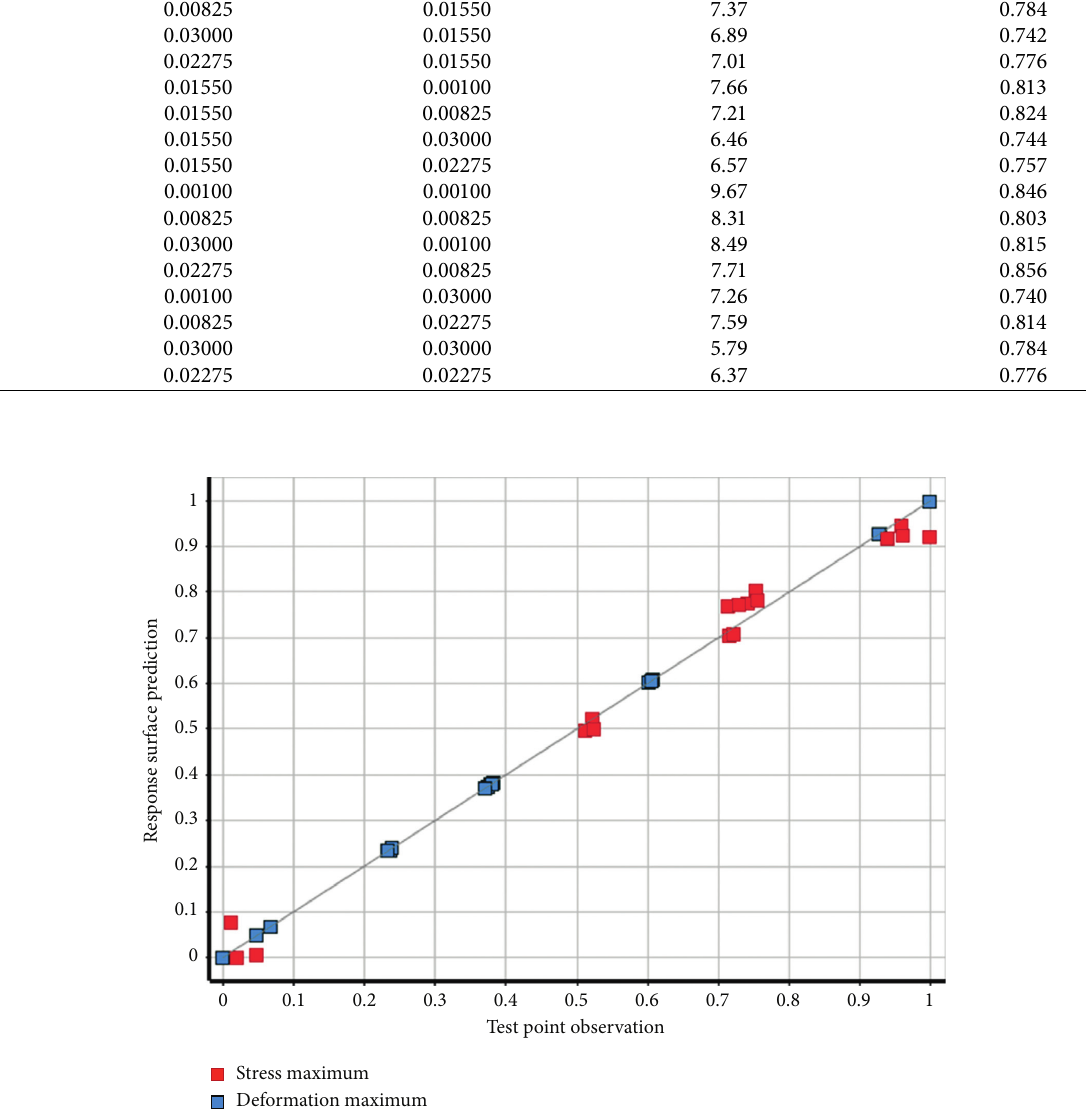
Figure 13: Predicted value and experimental